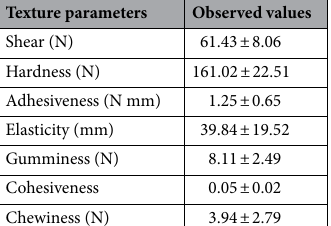
Table 4. Instrumental texture profile of the cereal bar.